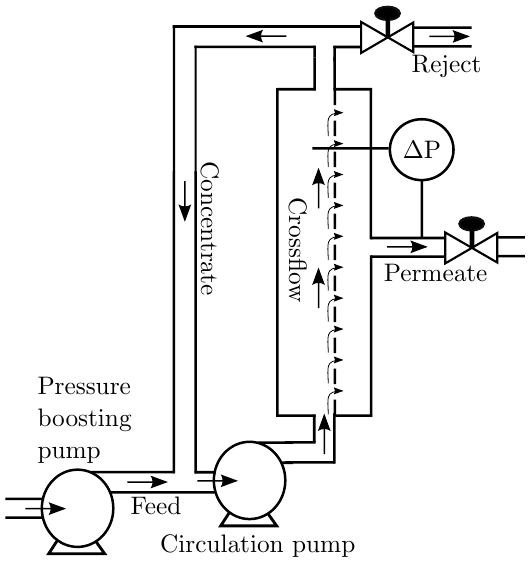
Figure 1. Membrane filtration